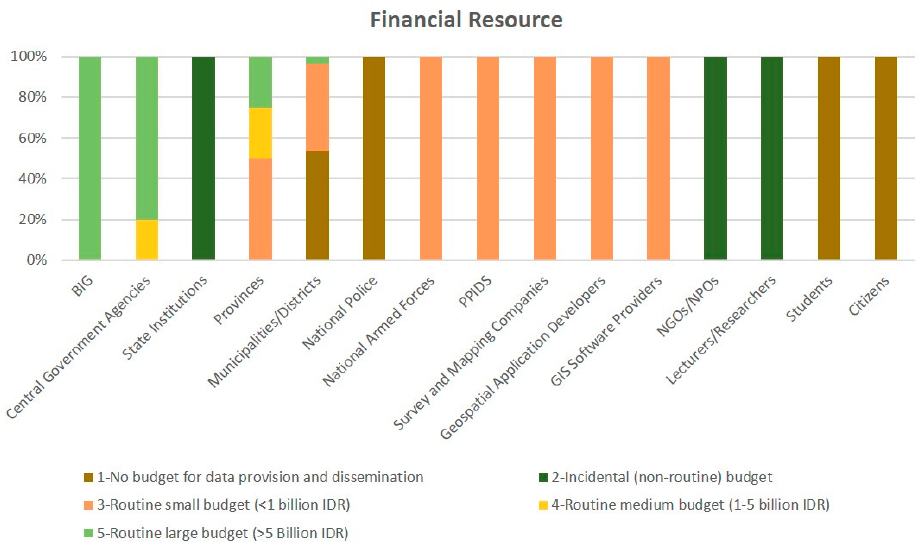
Figure 7. Questionnaire results on financial resources.